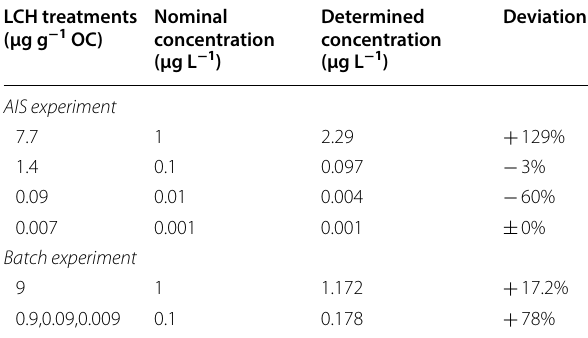
Table 4 Nominal and analysed LCH concentrations in the applied stock solutions for the AIS and the batch